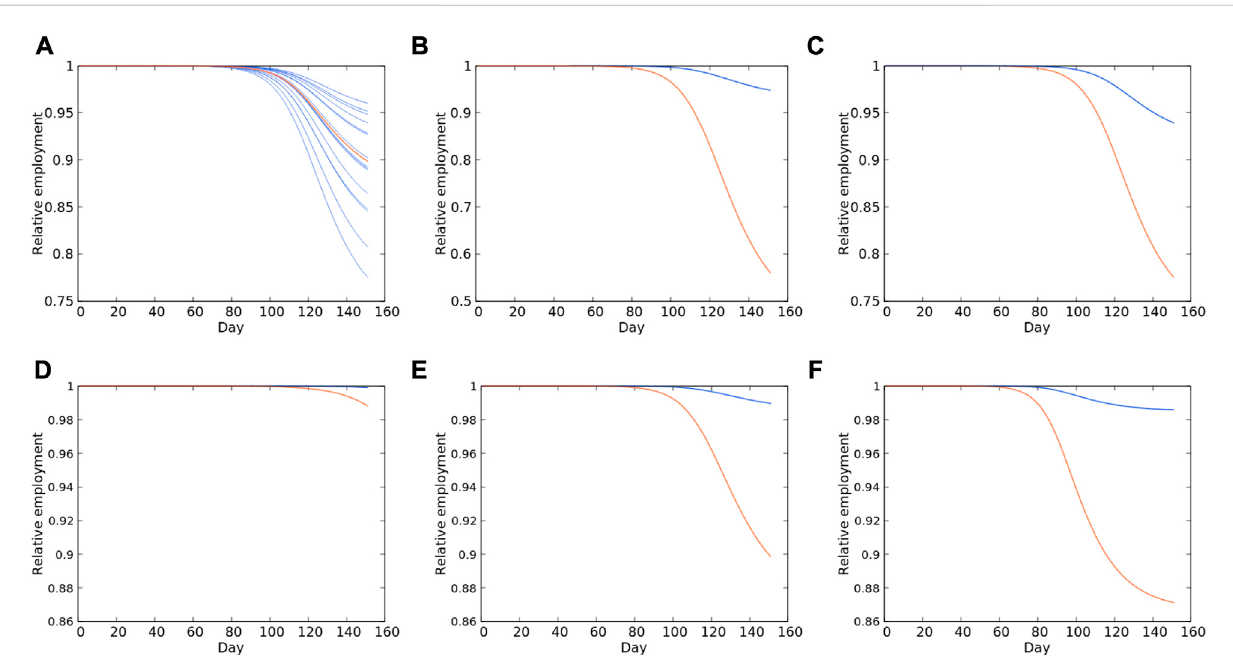
FIGURE 2 Examples of model results using the Fresno SES. Results are for simulations run at R 0 = 2.35, the estimated value on 1 March 2020. All trajectories in each plot are normalized against the initial values in the simulation, and are relative only to the other trajectories in the same plot. (A) Declining sector employments (blue) and total SES employment (red). (B) Employment cascade in the Manufacturing sector, disease-driven (blue) and subsequent cascade (red). (C) Cascades of the Education and Health sector (blue) and Manufacturing sector (red). (D – F) — Disease-driven and employment cascades for R 0 = 2.0, 2.5 and 3.0